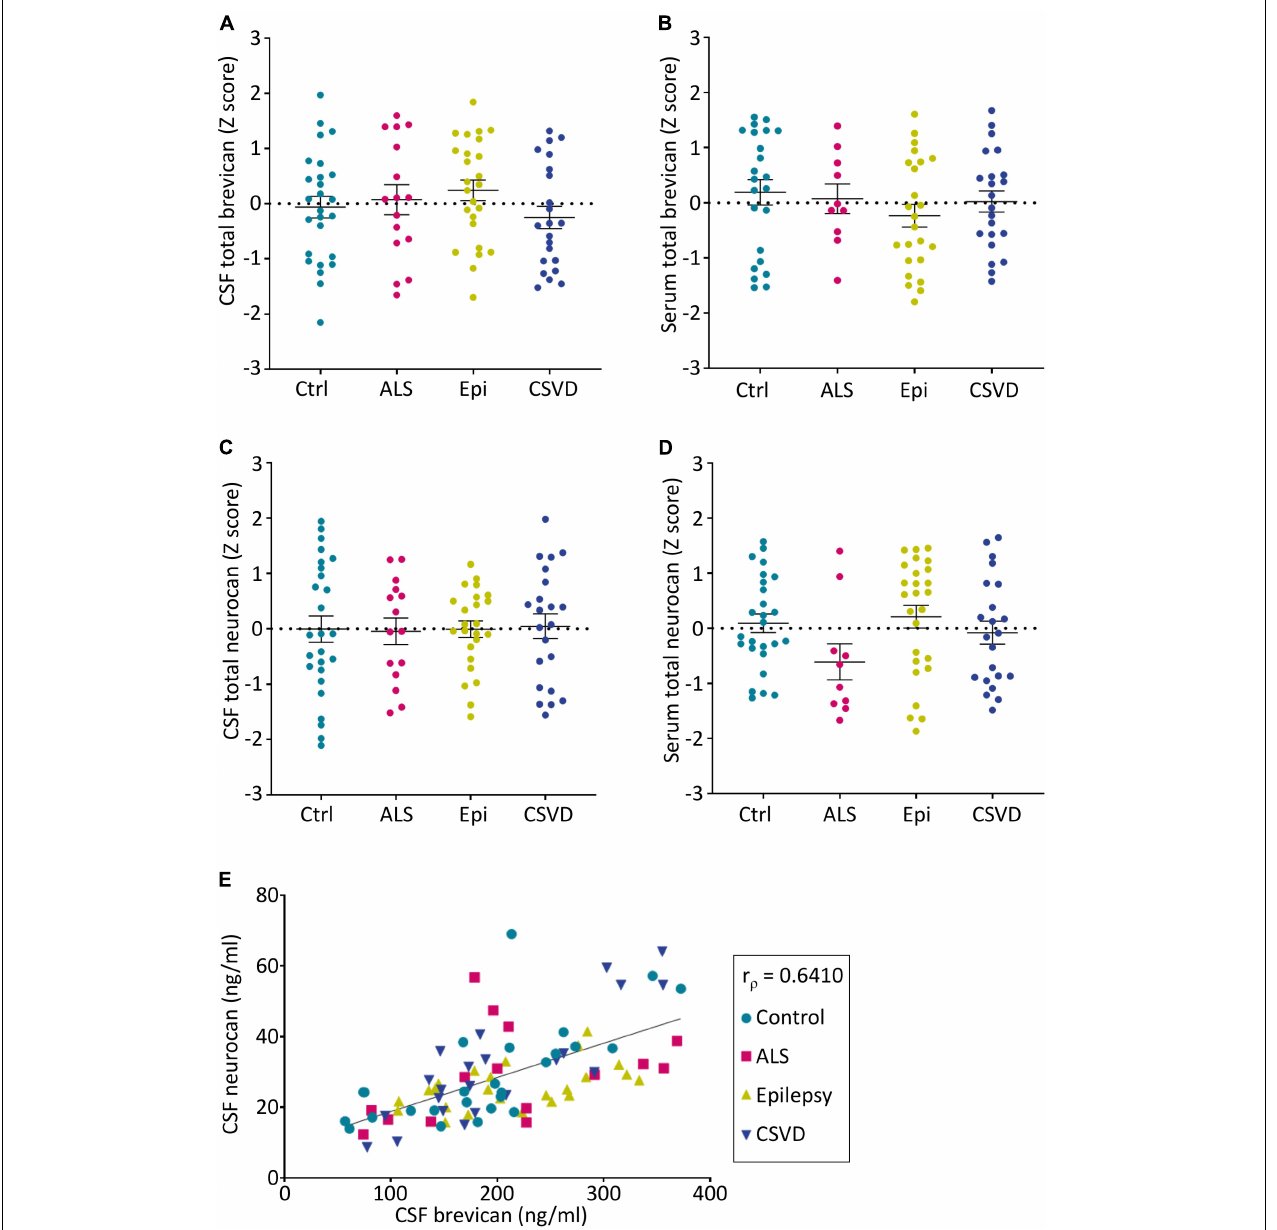
FIGURE 2 | Group-wise comparison of z-scores from age- and sex-corrected total levels of brevican (A,B) and neurocan (C,D) as measured via ELISAs in CSF (A,C) and serum (B,D) samples (CSF BCAN: Ctr. n = 26, ALS n = 16, Epi n = 25, CSVD n = 22; CSF NCAN: Ctr. n = 26, ALS n = 15, Epi n = 24, CSVD n = 22; Serum BCAN: Ctr. n = 23, ALS n = 10, Epi n = 24, CSVD n = 22; Serum NCAN: Ctr. n = 26, ALS n = 10, Epi n = 26, CSVD n = 22). No statistical significances were detected between groups. (E) The concentrations of total brevican and total neurocan in the CSF correlate with each other (r ρ = 0.6211, p < 0.0001). CSF, cerebrospinal fluid; Ctrl, control; ALS, amyotrophic lateral sclerosis; Epi, epilepsy; CSVD, cerebral small vessel